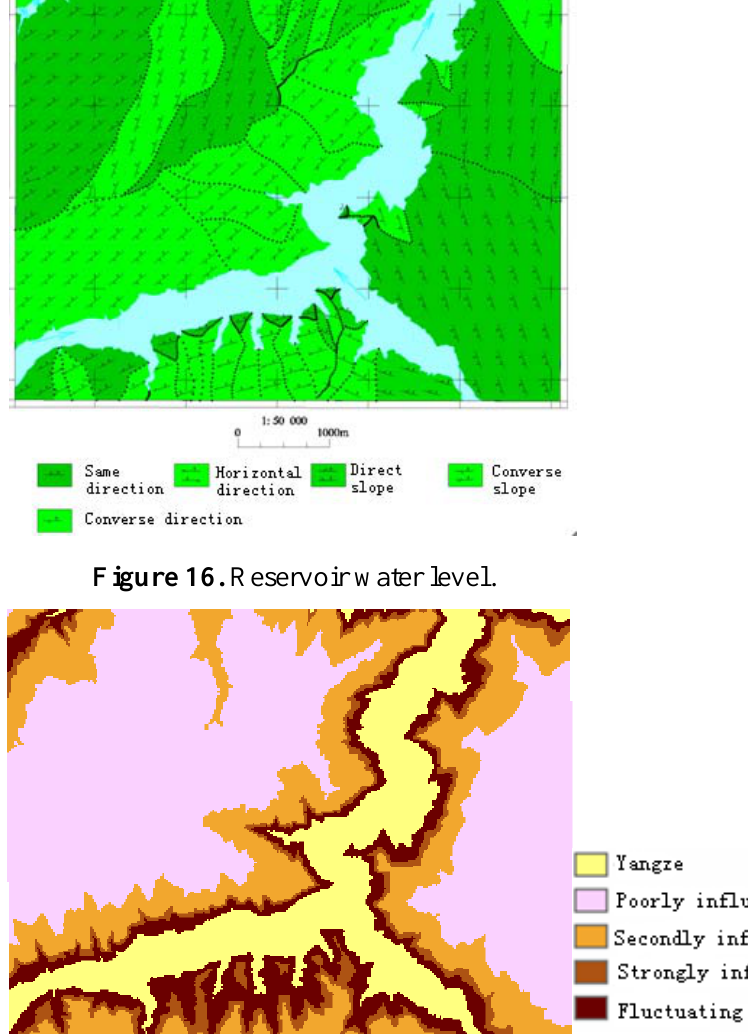
Figure 15. Slope structure image.